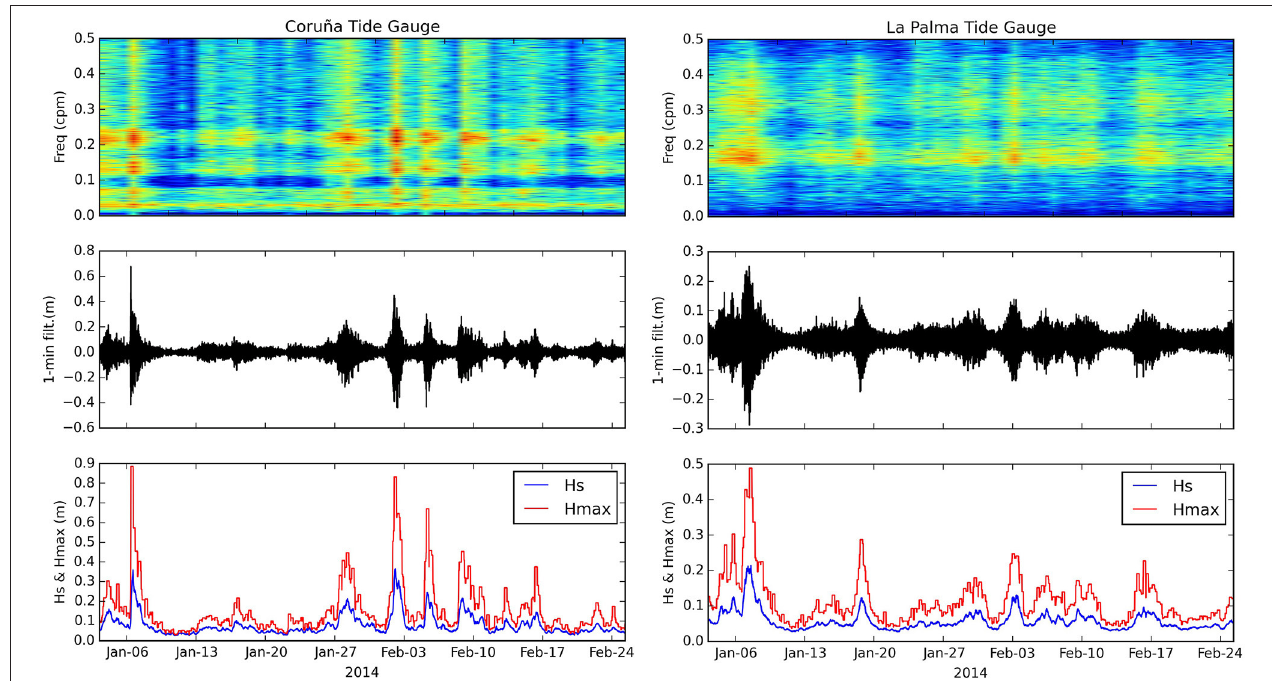
FIGURE 8 | Top: spectrogram of 1min high-pass filtered sea level data at Coruña (left) and La Palma (right) tide gauges, showing the daily variation of the spectra along the stormy period January–February 2014. Applied to 1536 points windows with 128 points overlap (colors in variance units). The storms coincide with the increase of energy on higher frequencies of sea level (periods 2 ′ –6 ′ ); middle and bottom: 1min high-pass filtered time series and estimated “seiche” amplitudes (half the significant wave height H s and maximum wave height H max ) at these stations during this period (zero-crossing procedure).